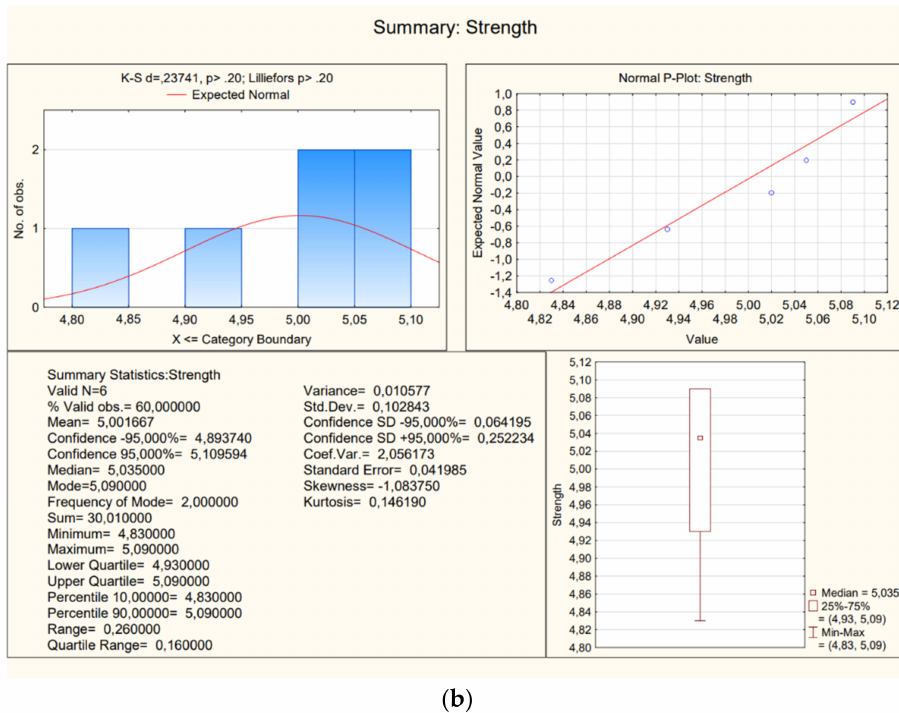
Figure 9. A view of statistics ( a ) samples 1a–1f; ( b ) samples 2a–2f. The values of internal forces in the vault were determined using Robot Autodesk Structural Analysis. The selected calculation results are shown on Figure 10, which shows an example of the calculation results.